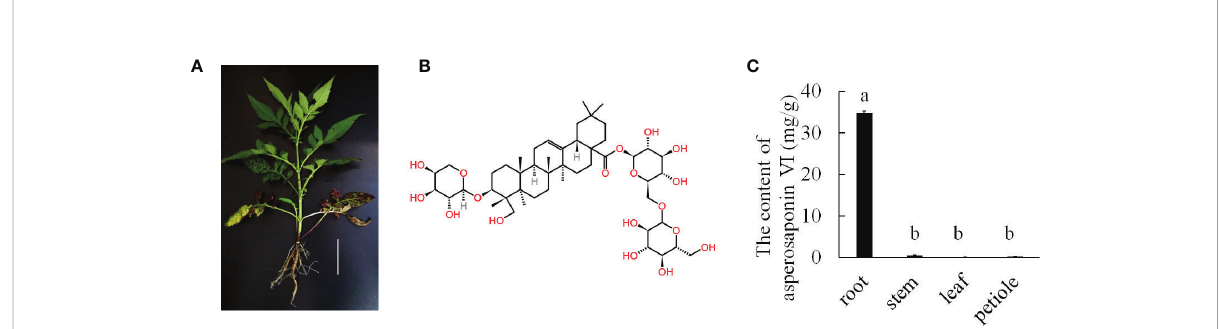
FIGURE 1 The major medicinally active triterpenoid in D. asperoides . (A) , the plant of D. asperoides . Scale bar = 10 cm. (B) , the typical triterpenoid of asperosaponin VI. (C) , the content of asperosaponin VI in different tissues of D. asperoides . The error bars represent the standard deviation with at least three biological replicates. Different lowercase letters denote signi fi cant differences by multiple comparisons using Statistix 8.0